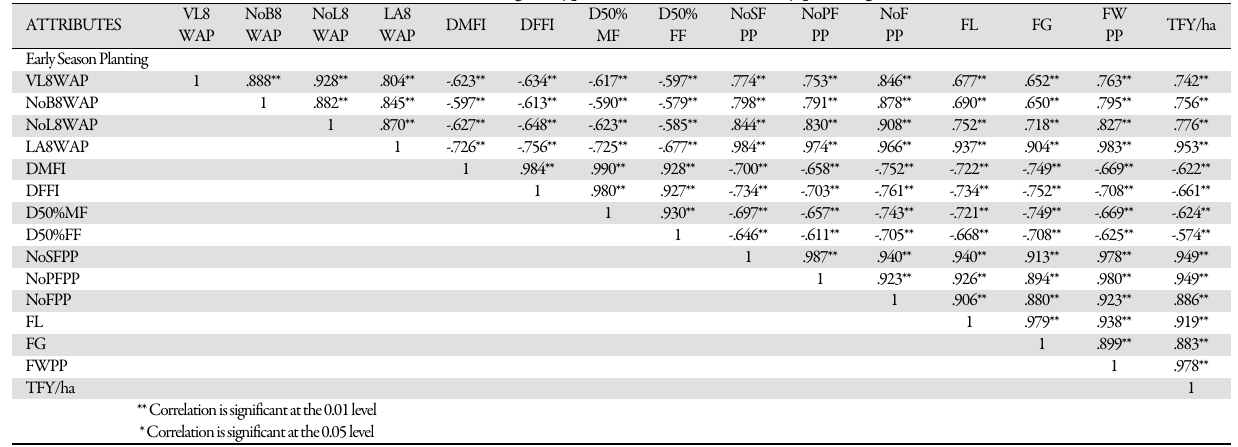
Table 6. Correlation coefficient for 15 traits of cucumber genotypes evaluated in 2014 early planting season VL8 ATTRIBUTES WAP